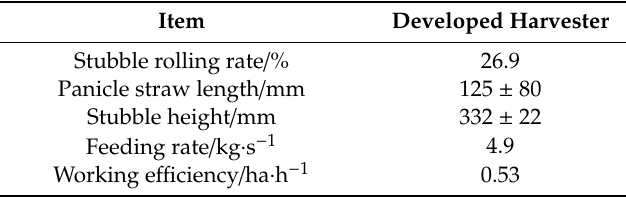
Table 3. The results of the comparative